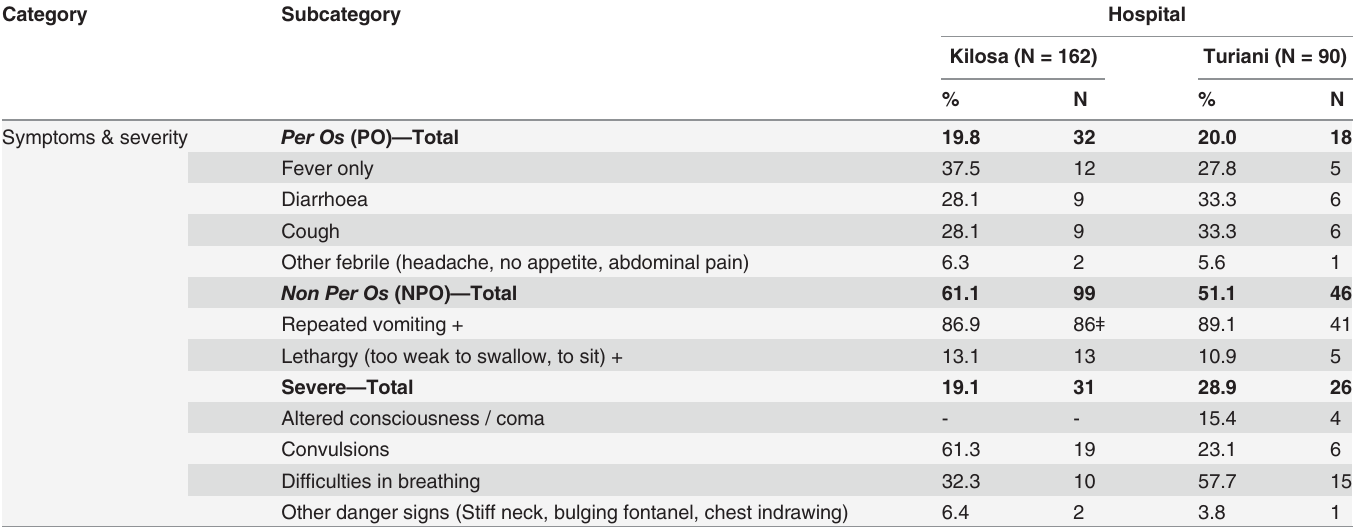
Table 5. Symptoms and severity of acute febrile illness for the participants interviewed at the hospital. Category